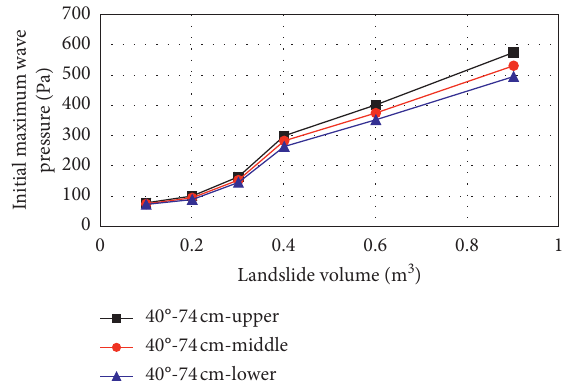
Figure 9: Variation of initial maximum wave pressure at upper, middle,andlowermeasuringpointswithlandslidevolume(40 ° ,74cm).